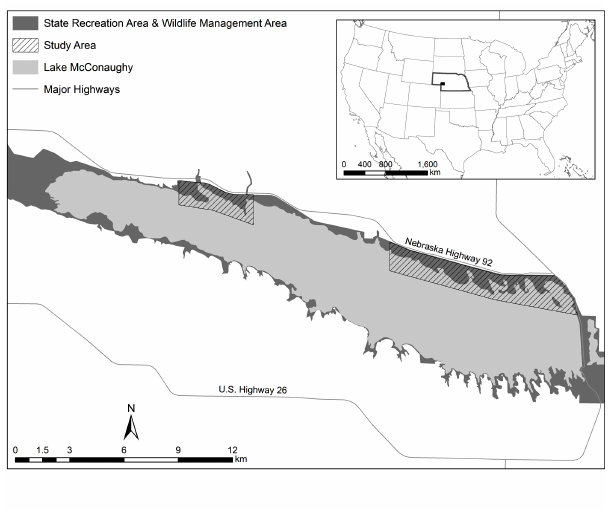
Fig. 1 . Piping Plover ( Charadrius melodus ) nesting areas at Lake McConaughy, Keith County, Nebraska,